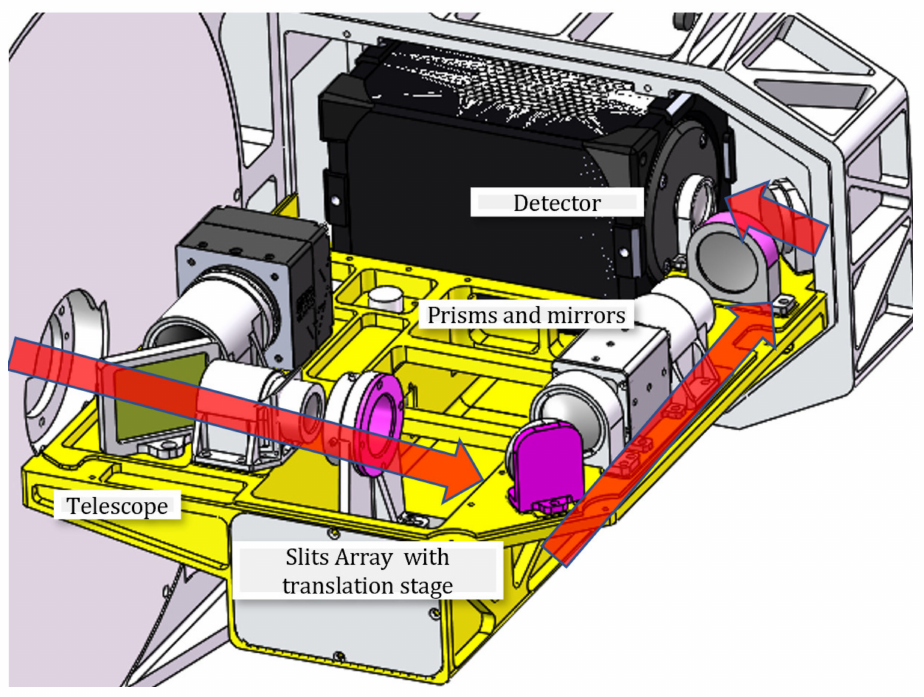
Figure 4. System design